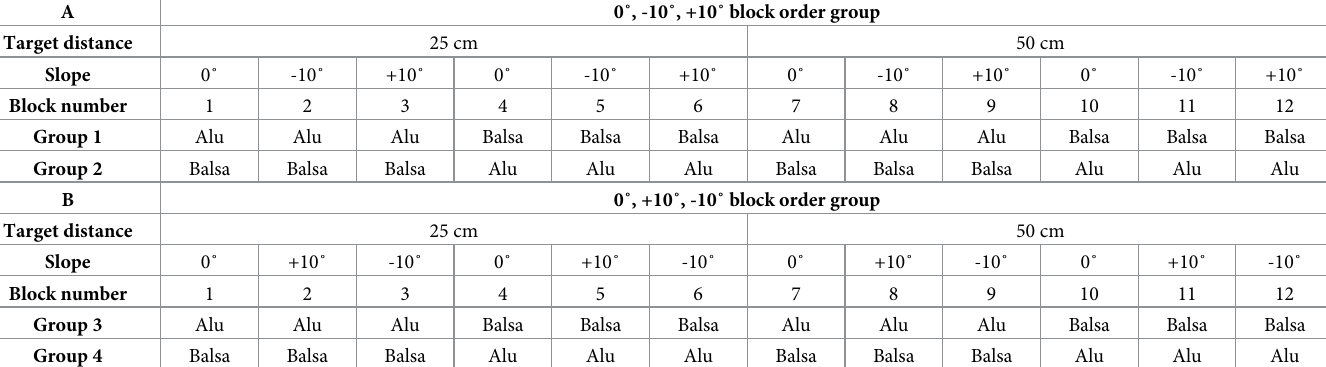
Table 1. Description of the block order used in the Experiment in each group, whether A) the “0˚, -10˚, +10˚” block order group, or B) the “0˚, +10˚, -10˚” block order group. Each block order group was subdivided in two subgroups: One beginning with aluminum (alu) followed by balsa wood (balsa), and the other in the opposite